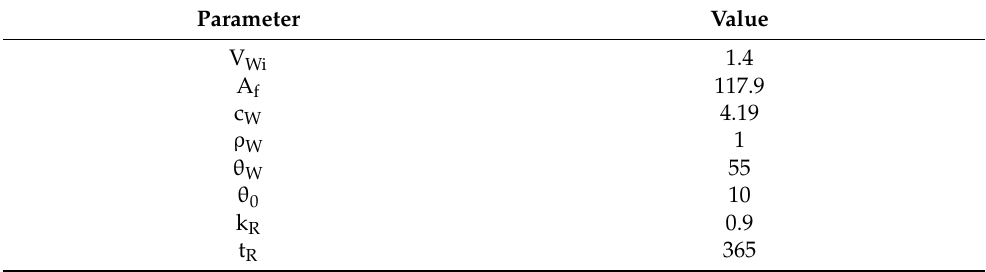
Table 1. Calculation parameters to determine the heat needed to prepare domestic hot water.